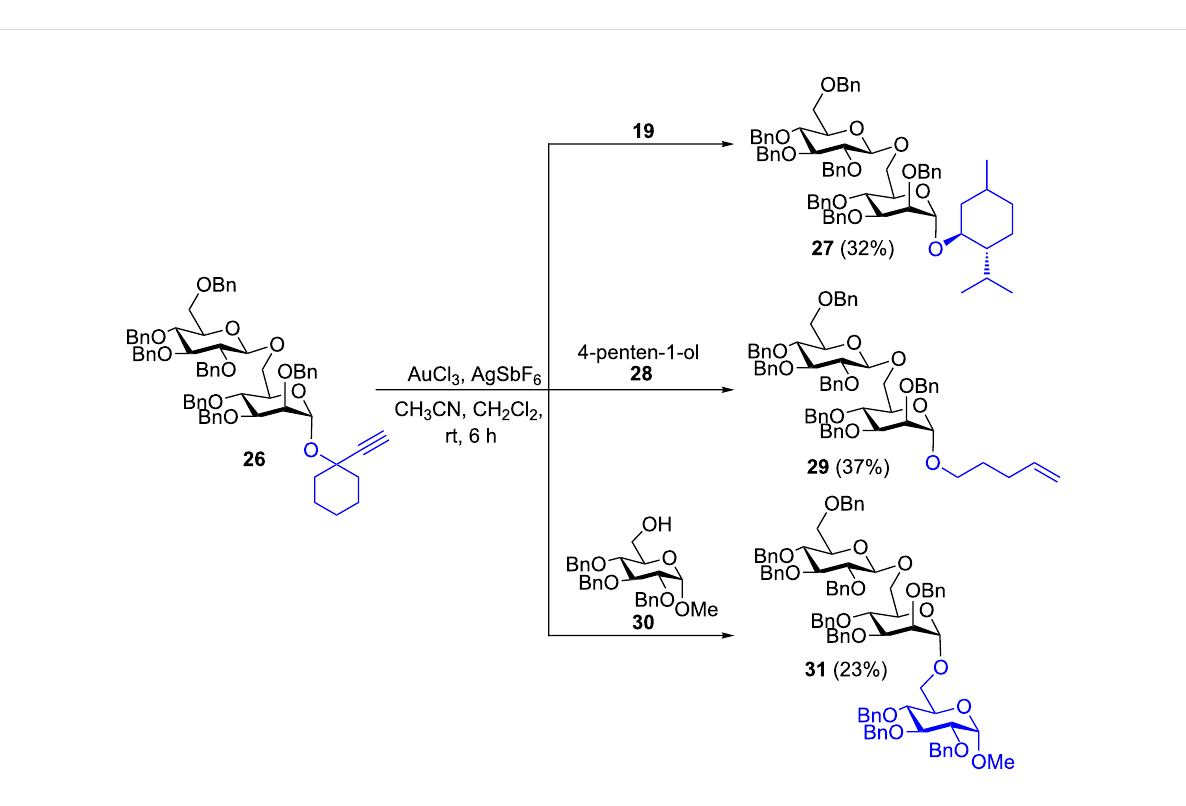
Scheme 6: Gold-catalyzed glycosidation at ambient temperature for the synthesis of higher